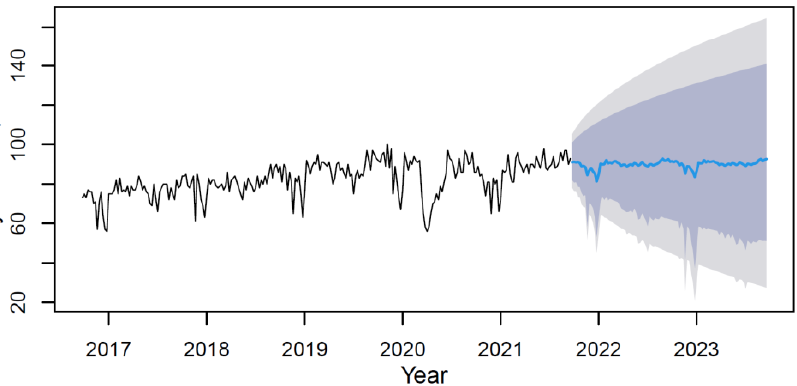
Figure 10. The psychiatrist’s data time series plot (solid black line) with forecast (solid blue line) on light grey (95% CI) and dark grey (80% CI) backgrounds by applying the M3 hybrid model.